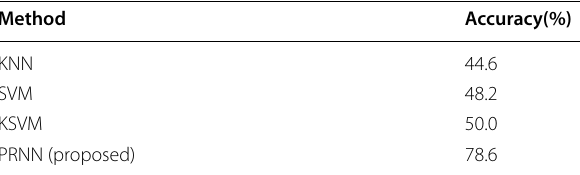
Table 7 Crack position identification results obtained by different crack diagnosis methods on the test